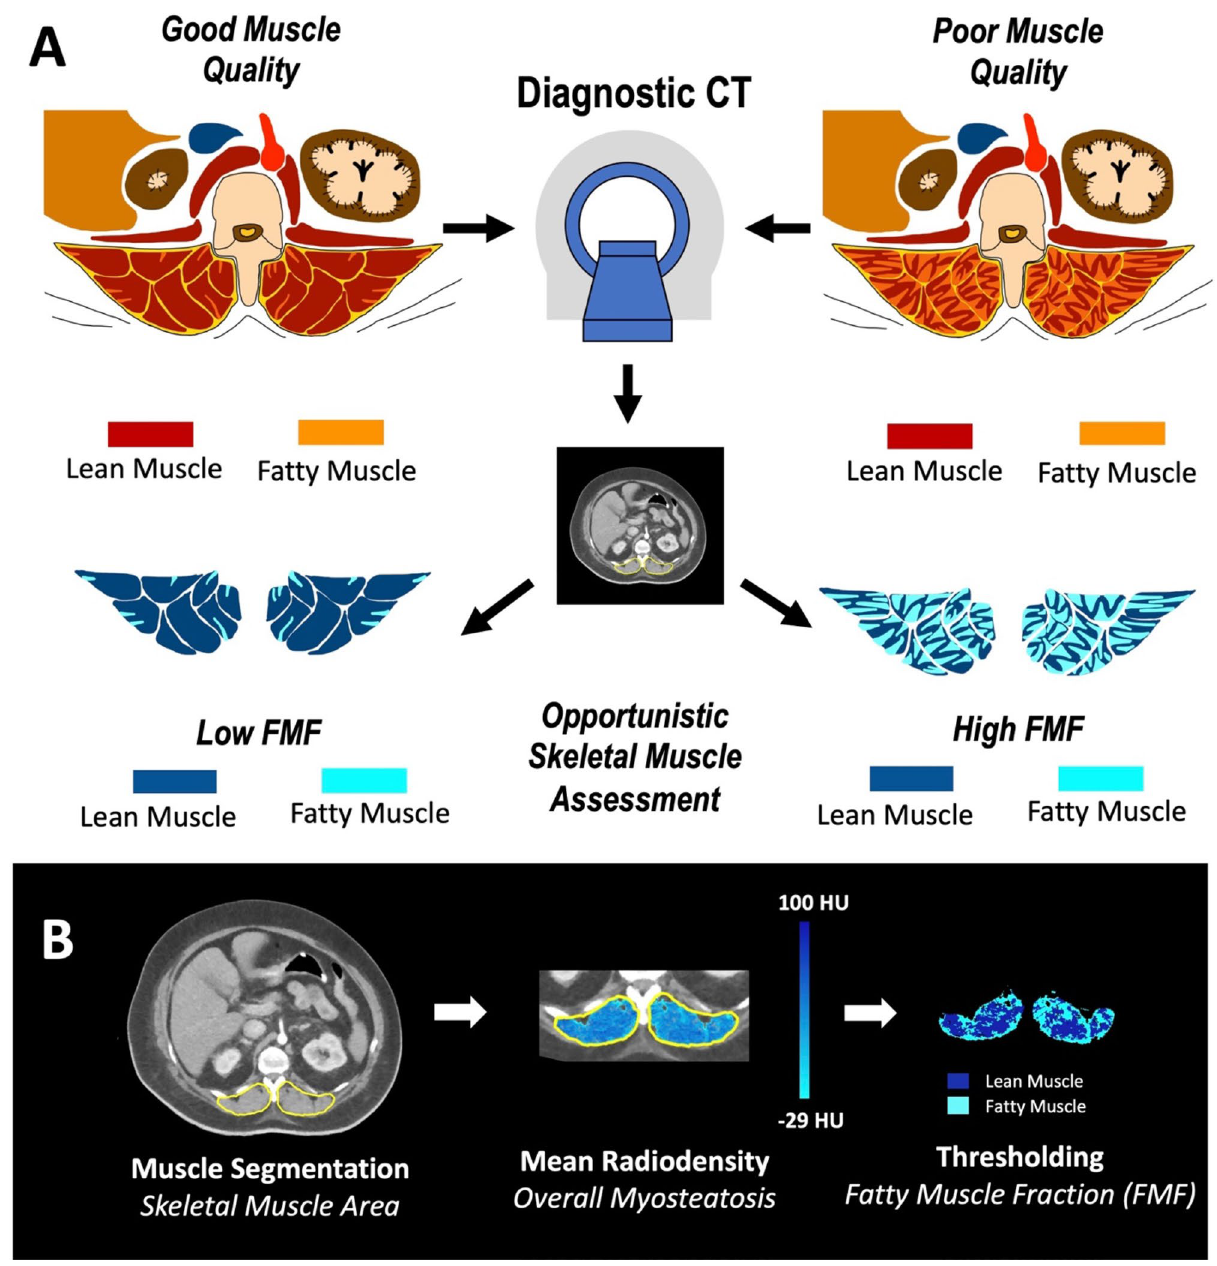
Figure 2. The concept of FMF. ( A ) Skeletal muscle fat infiltration is considered an indicator of muscle quality. Based on densitometric thresholds and accepted cut-off values of lean and fatty skeletal muscle, muscle compartments may be separated into areas of fatty and lean muscle. The FMF is calculated as the area of fatty muscle tissue related to the total skeletal muscle area, resulting in a relative and comparable measure of muscle quality. This biomarker can be opportunistically obtained from clinical CT scans. ( B ) Skeletal muscle area was obtained as the bilateral compartment area of paraspinal skeletal muscles at the level of the superior mesenteric artery. Within the skeletal muscle area, muscle tissue is identified by an attenuation threshold range of 100 to − 29 HU. Mean Radiodensity was highlighted to visualize overall muscle fat infiltration (myosteatosis). Based on thresholds ranges of − 29 to 29 HU for fatty muscle and 30 to 100 HU for lean muscle, FMF was calculated. CT Computed tomography, FMF Fatty muscle fraction, HU Hounsfield